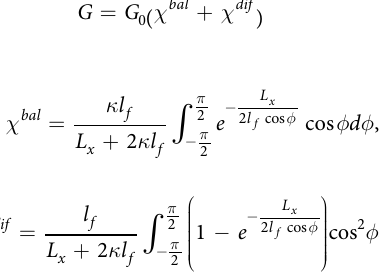
χ χ = + G G ( ) (15) bal dif 0